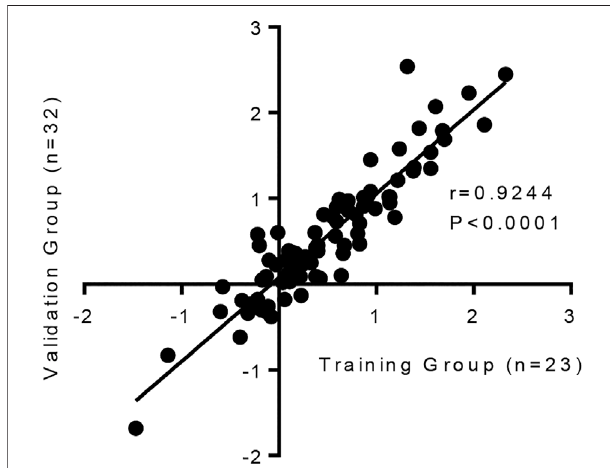
FIGURE4| Thehumanlung responsetoTGF β 1exposureisconsistent, with a strong correlation in the changes of mRNA expression for 84 fi brosis- associated genes between our previous published work ( n (cid:1) 23 human lung donors) (Roach et al., 2018) and the subsequent n (cid:1) 32 human samples we have tested in this study ( p < 0.0001, r (cid:1) 0.9244).